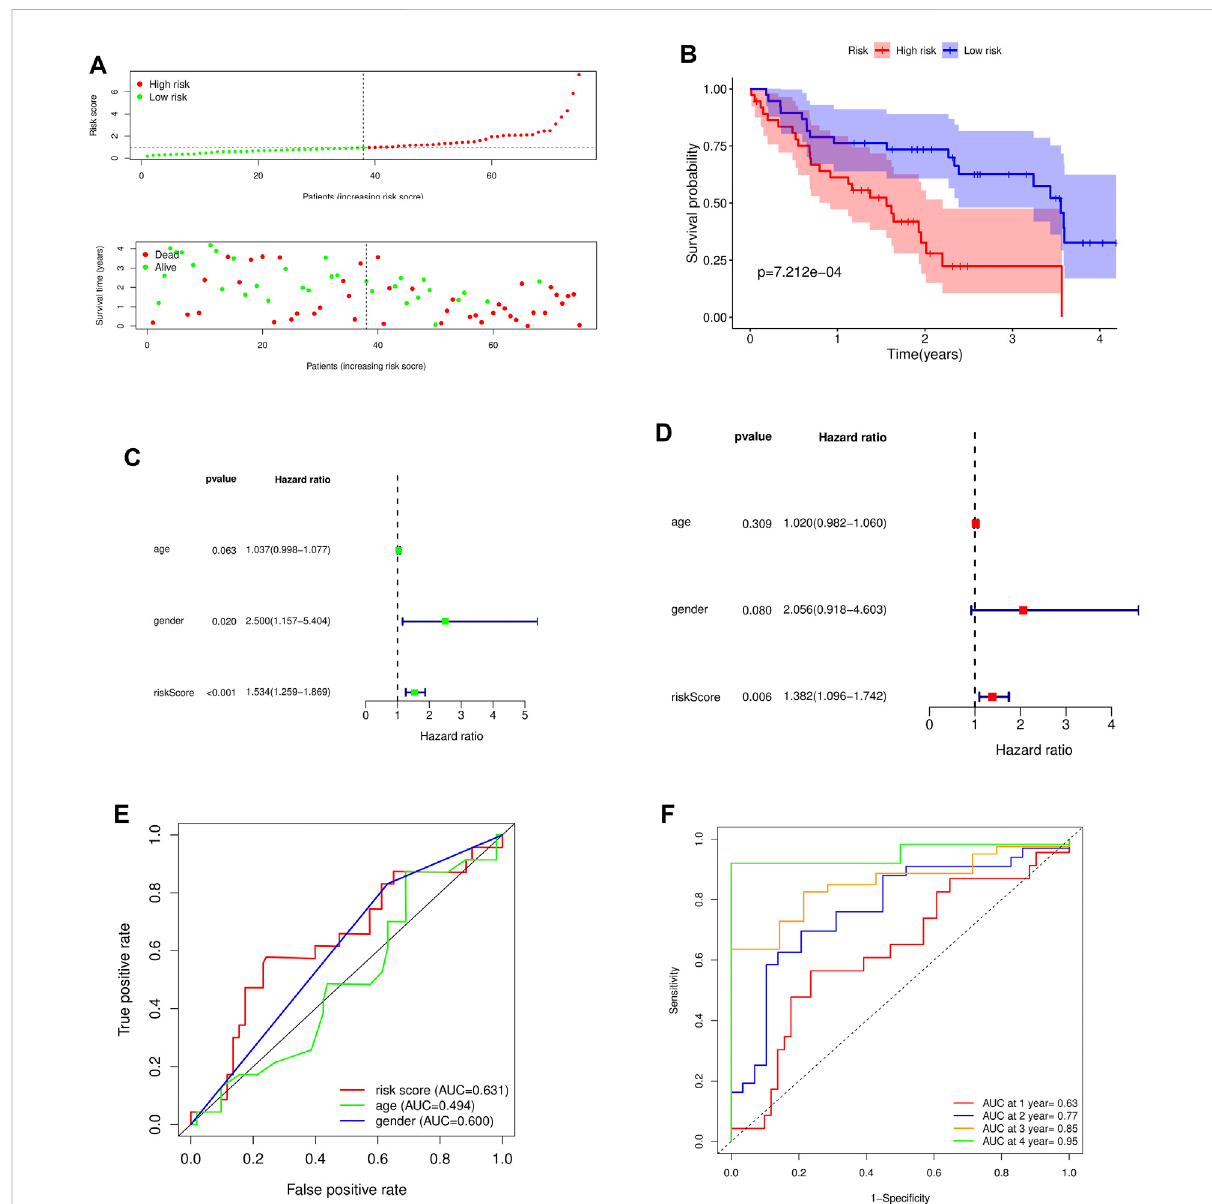
FIGURE 5 Survival analysis and independent prognostic analysis of the prognostic risk model. (A) Distribution of patients in different risk groups and risk levels; (B) Overall survival curve of the model; (C) Univariate independent prognostic analysis; (D) Multivariate independent prognostic analysis; (E) ROC curve of different factors (riskscore, age, gender); (F) ROC curve of different years (1, 2, 3 and 4